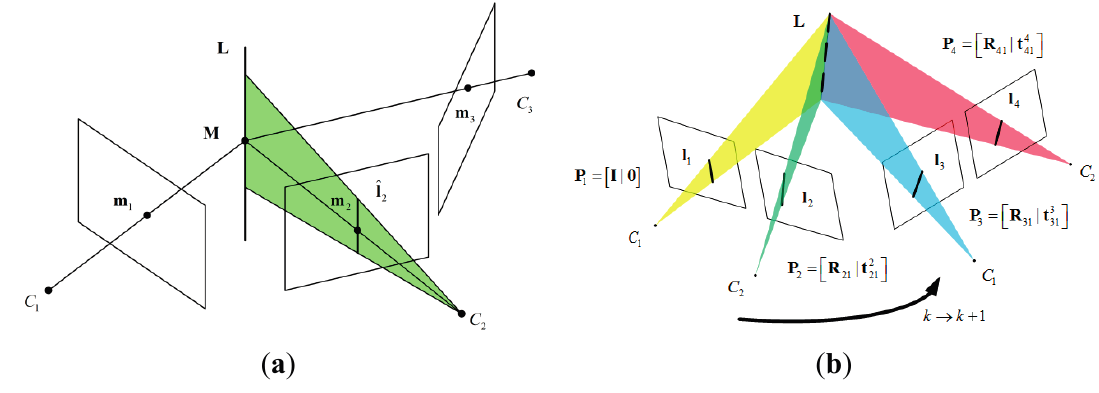
Figure 1. ( a ) The point-line-point correspondence among three views; ( b ) Stereo geometry for two views and line-line-line